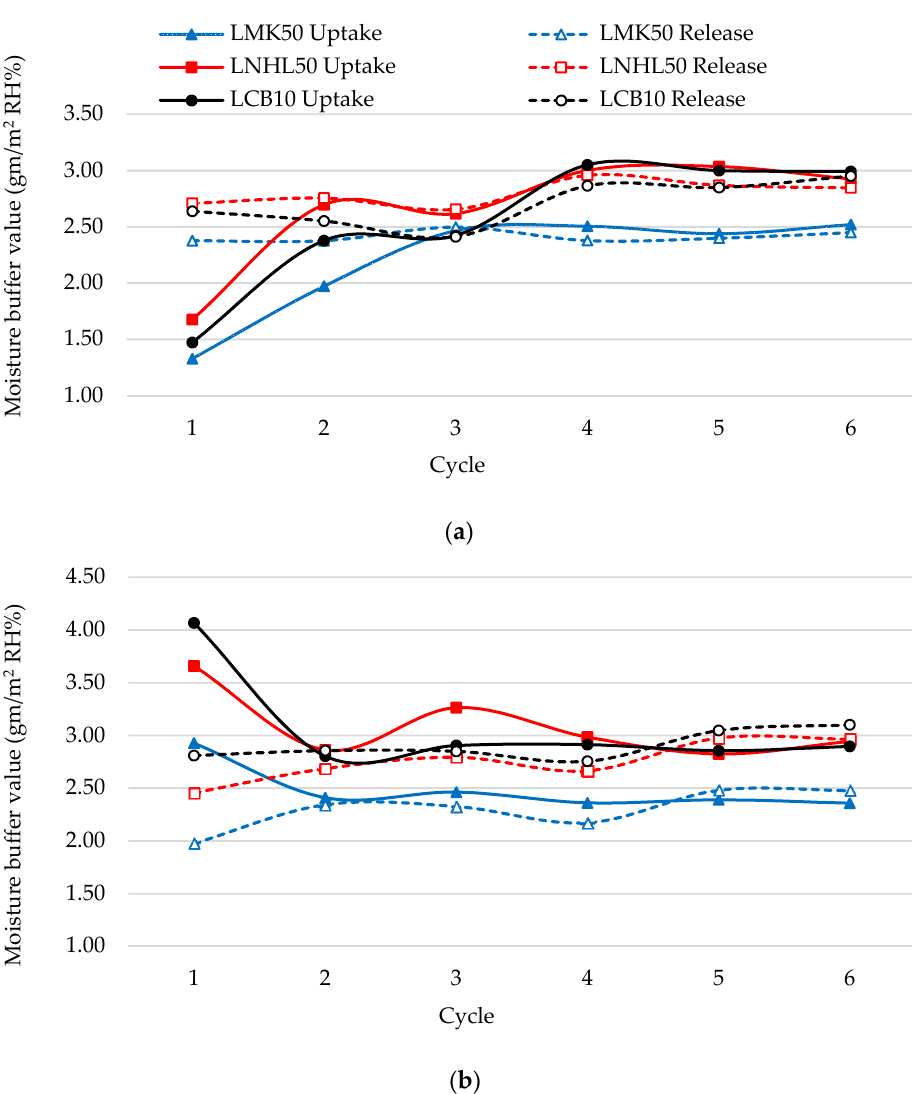
Figure 5. Moisture buffer value with cycles with different initial conditions. ( a ) High moisture content initial condition; ( b ) Low moisture content initial condition.